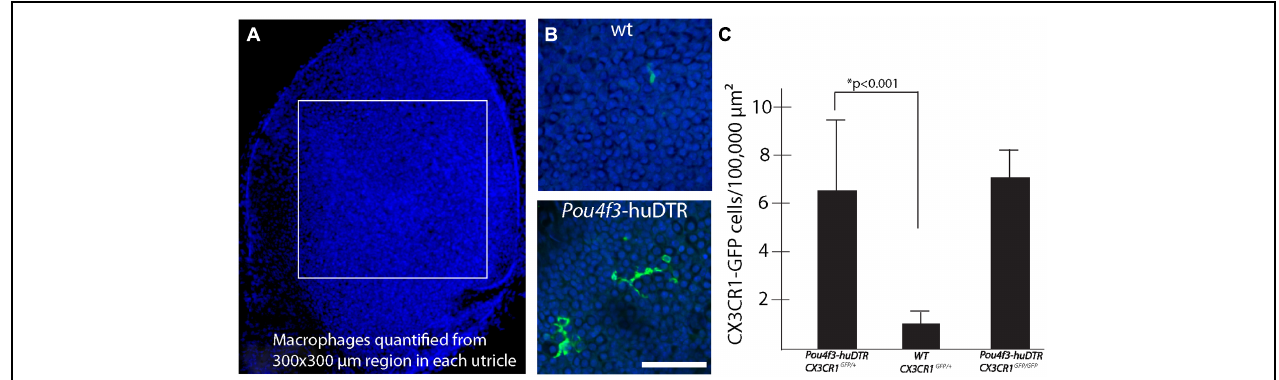
FIGURE 4 | Hair cell lesion increases the numbers of macrophages in the sensory epithelia of mouse utricles. (A) Confocal image stacks were obtained from 300 µ m × 300 µ m regions in the central portion of mouse utricles. (B) Examination of the DAPI-labeled nuclei of hair cells and supporting cells (blue) was used to determine the vertical extent of the sensory epithelium and the total number of GFP-labeled macrophages (green) within the sensory